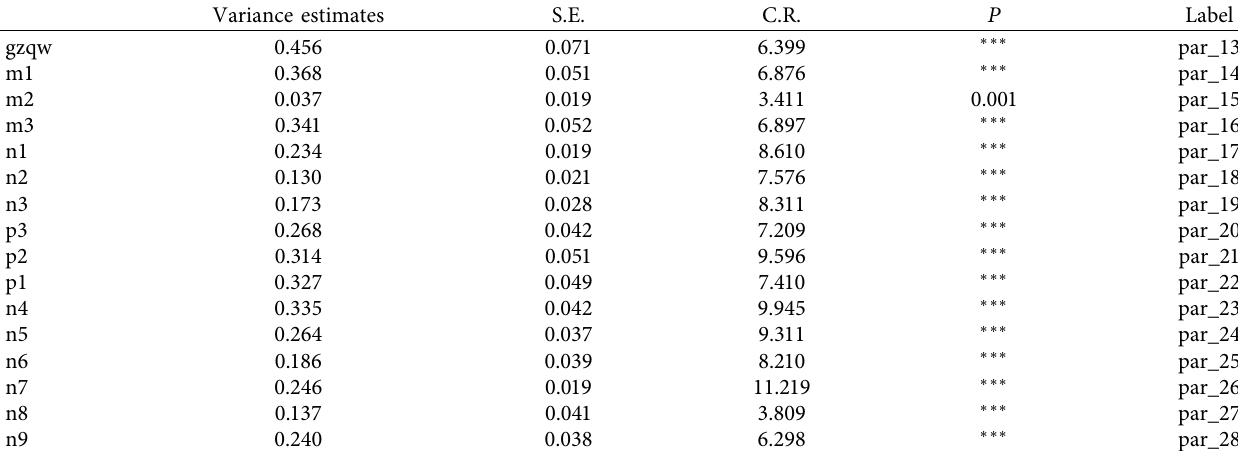
Table 4: Variance